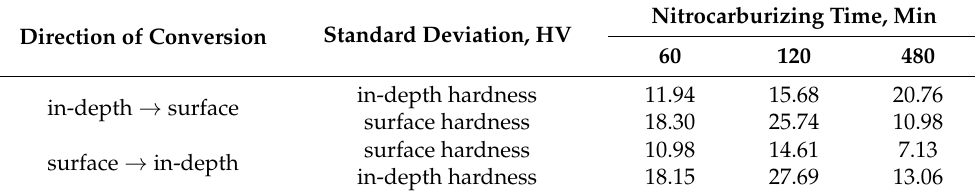
Table 6. Standard deviation between measured and calculated surface hardness values.